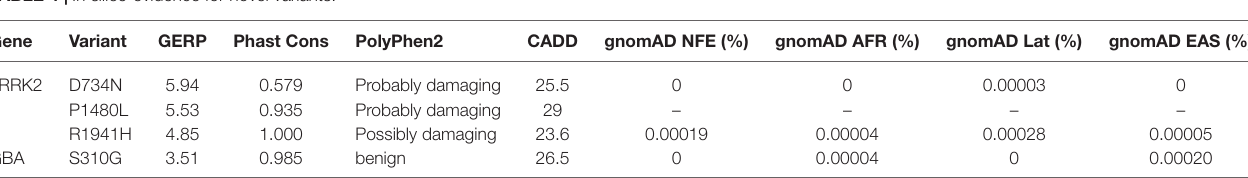
TABLE 4 | In silico evidence for novel